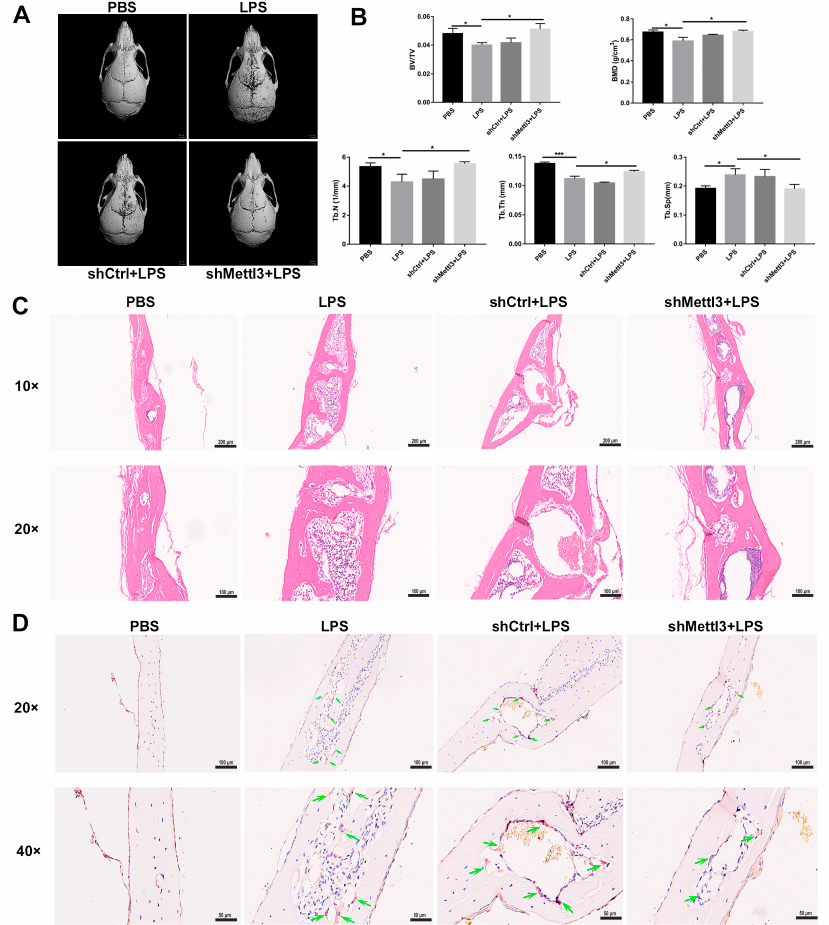
Figure 7. The effect of METTL3 interference on LPS-induced osteolysis in mouse calvaria. ( A ) Rep- resentative micro-CT reconstruction images of the murine calvaria from each group. ( B ) Quantita- tive analysis of the bone volume against tissue volume (BV/TV), bone mineral density (BMD), tra- becular number (Tb. N), trabecular thickness (Tb. Th) and trabecular separation (Tb. Sp). ( C , D ) The calvarial bone slices were stained with H&E and TRAP. ( C ) Histological slide images of H&E stain- ing at 10× and 20× magnification. ( D ) Images of TRAP staining at 20× and 40× magnification. Upper scale bars, 100 μ m; lower scale bars, 50 μ m. The green arrows indicate osteoclasts. The data repre- sent the mean ± SD ( n = 3). * p < 0.05; *** p < 0.001.